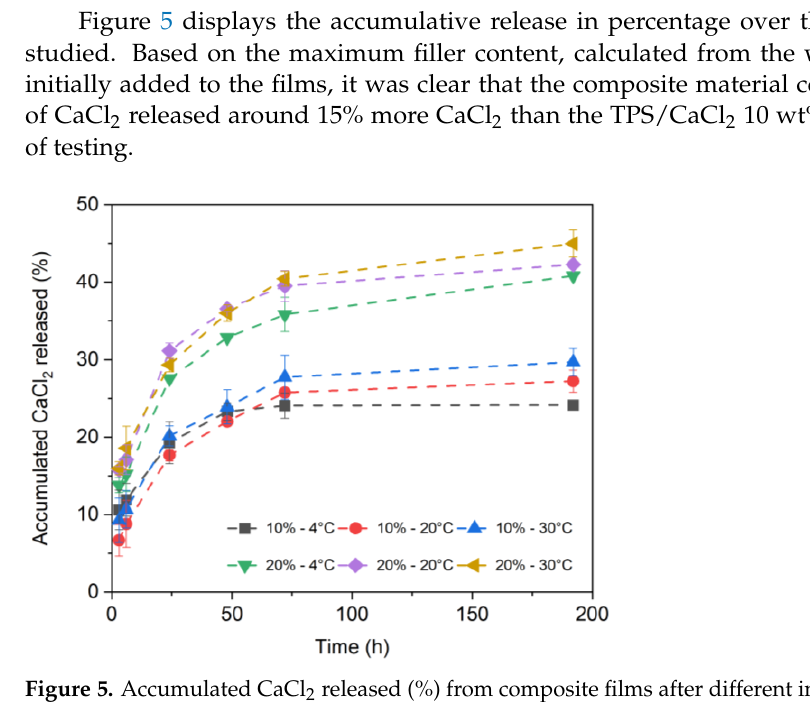
Figure 5. Accumulated CaCl 2 released (%) from composite films after different incubation periods at 4, 20 and 30 °C.